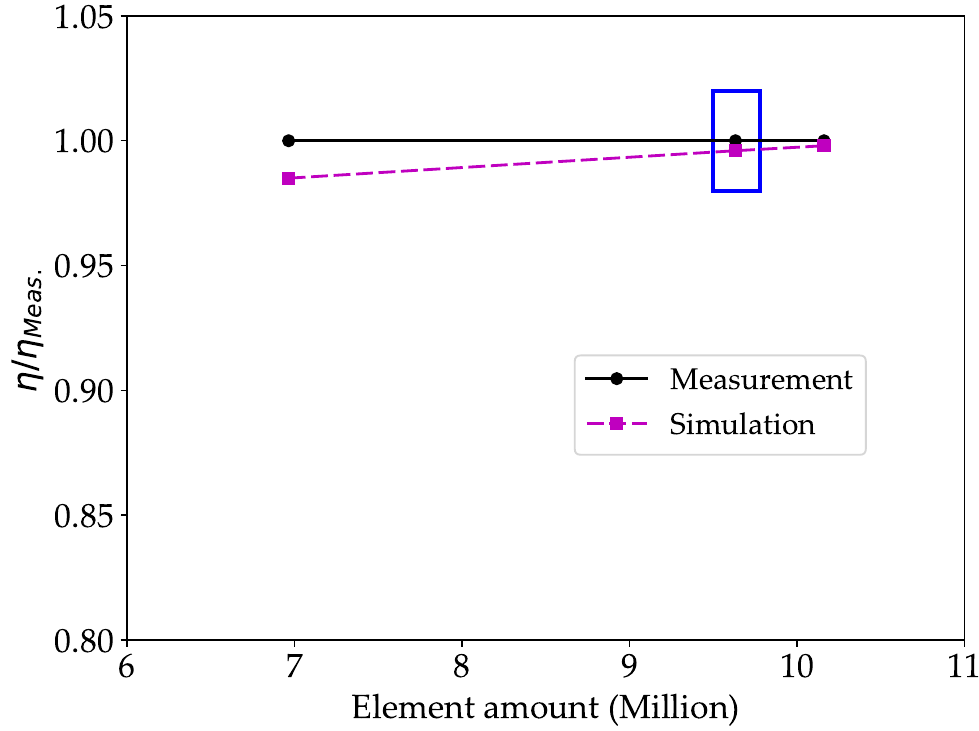
Figure 5. Mesh sensitivity analysis of the CFD simulation.